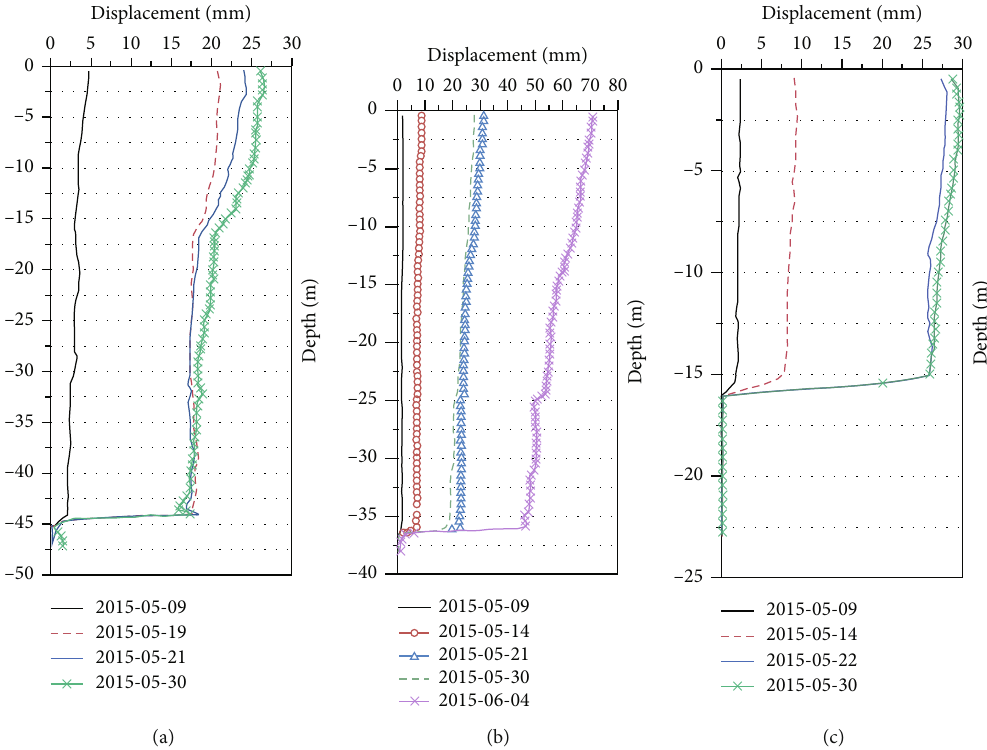
Figure 5: Deep displacement: (a) IN